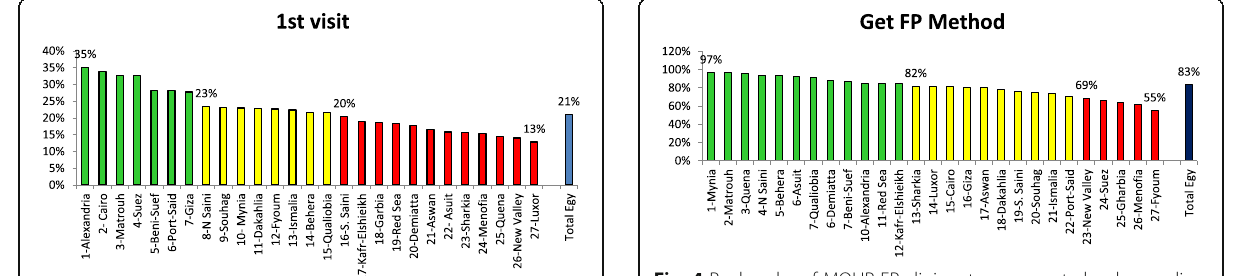
Fig. 4 Rank order of MOHP-FP clinics at governorate level according to the percent of clients reported attendance to FP clinics to get FP methods